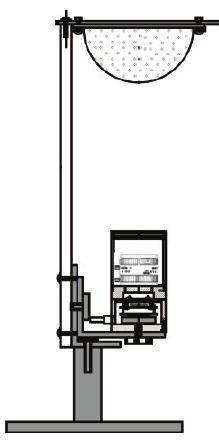
Figure 6: The design of the vision-based localization system, composed of a camera pointed upwards to a spherical